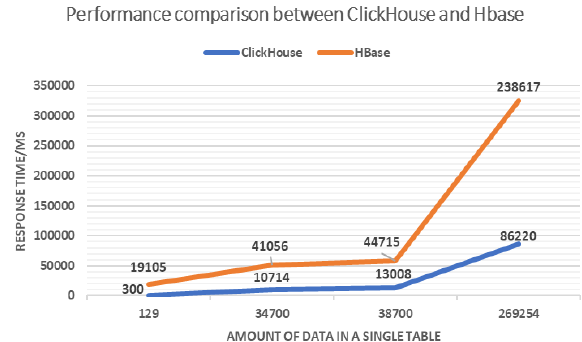
Figure 6 . The minimum bounding rectangle of two polygons intersects, but the polygons do not